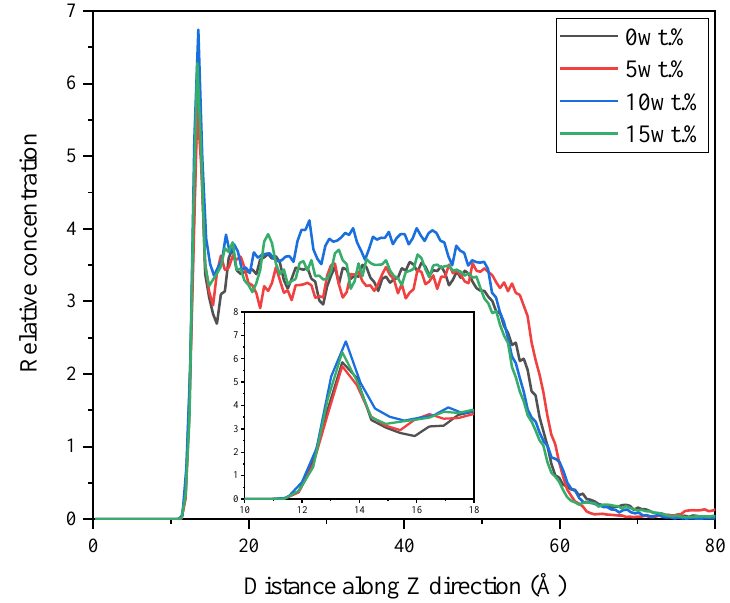
Figure 9. The atom relative concentration of different systems along Z direction.